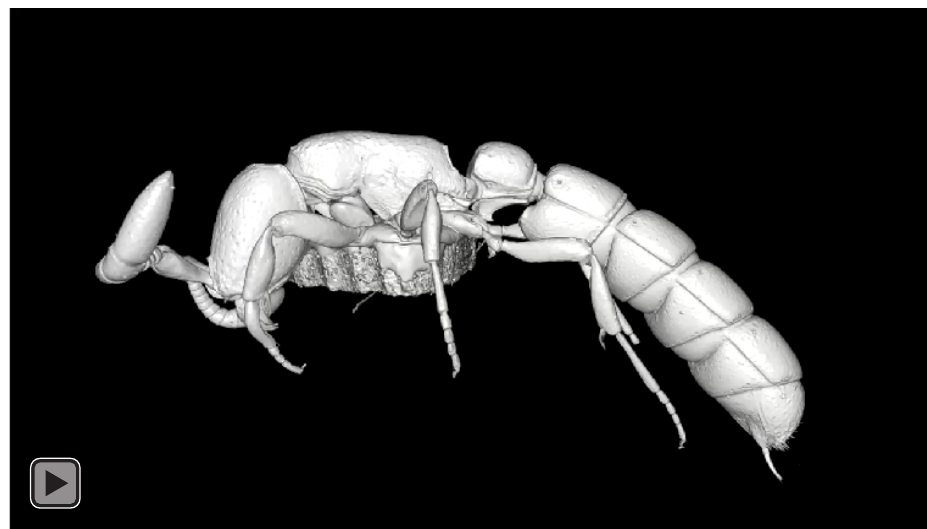
Video 3. 3D rotation video of Zasphinctus wilsoni sp. n. holotype worker (MCZ-ENT-00512764) based on shaded volumetric surface rendering of full